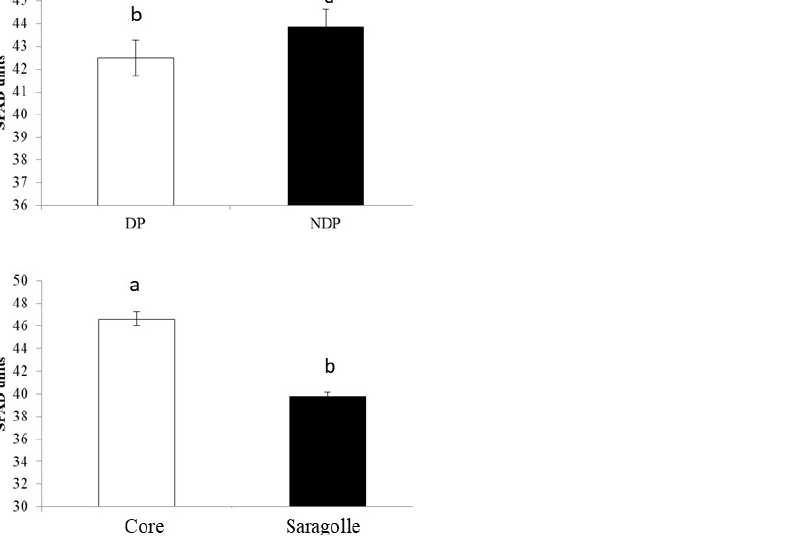
Figure 3. Main effect of clipping management ( top ) and variety ( bottom ) on SPAD index. Bar plots of the means overlaid by standard error bars. Lower letters above the columns indicate significant differences between values ( p -value < 0.05).